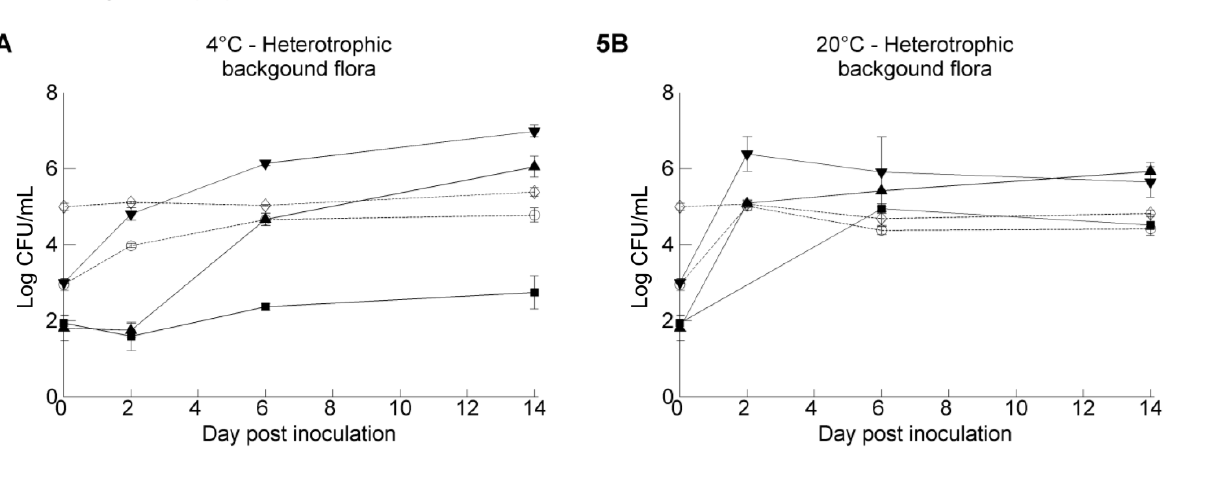
Figure 5. Plate counts of heterotrophic background microbiota residing in the five irrigation water samples (Ground Water 1 (  ), Ground Water 2 (  ), Ground Water 3 (  ), Pond Water 1 (  ), Pond Water 2 (○)) stored at 4 °C (A) and 20 °C (B) . The data show the mean of three analyzed vials and are calculated from the log transformed values of the heterotrophic background population size. Error bars indicate standard